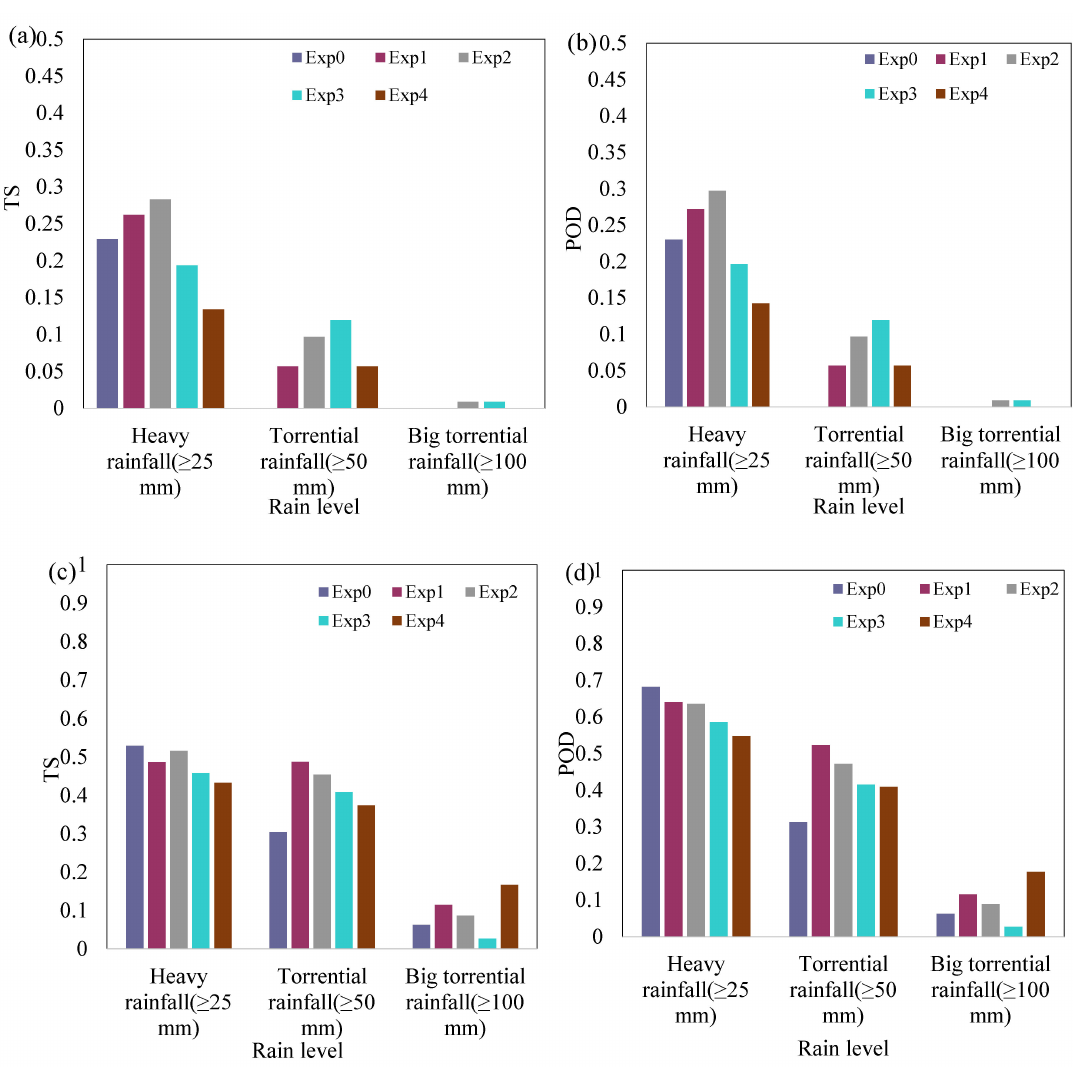
Figure 11. Evaluation indexes of the 24 h cumulative rainfall from 00:00 to 23:00 on 20 July. ( a , b ) are the results of the model started at 00:00 on 18 July, ( c , d ) are the results of the model started at 00:00 on 19 July, ( a , c ) show the TS values, ( b , d ) show the POD